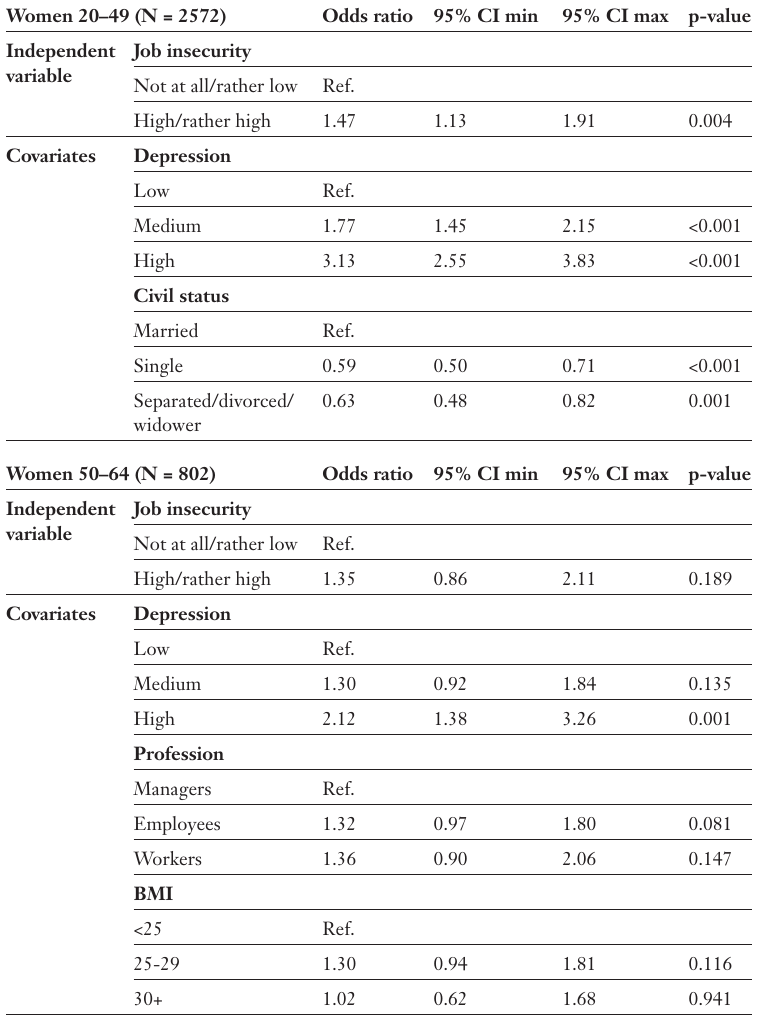
Women: logistic regression models of predictors of decrease in sexual